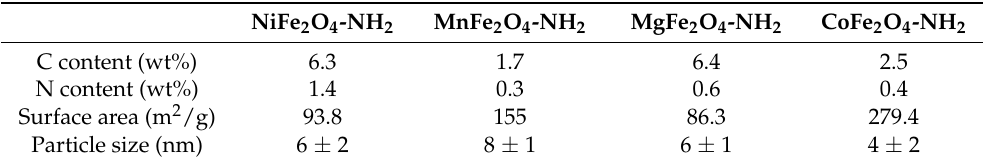
Table 1. Carbon content, specific surface area and average particle size (based on XRD) of the ferrite